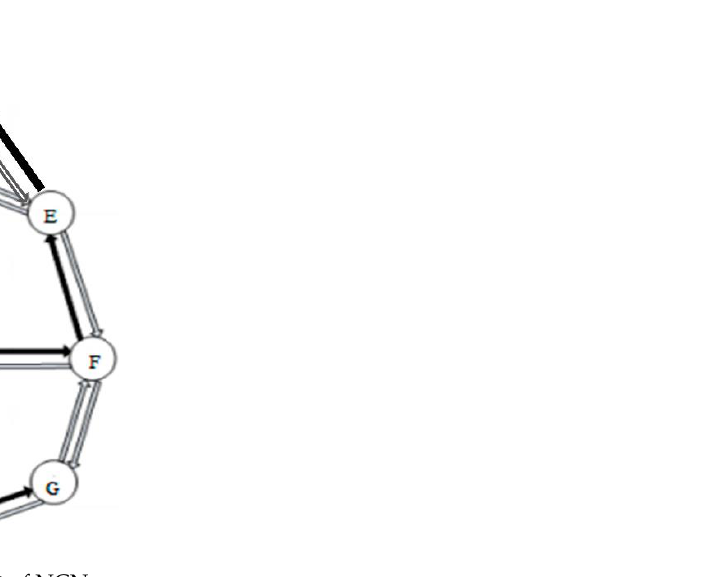
Figure 3. Connectivity list of NCN.